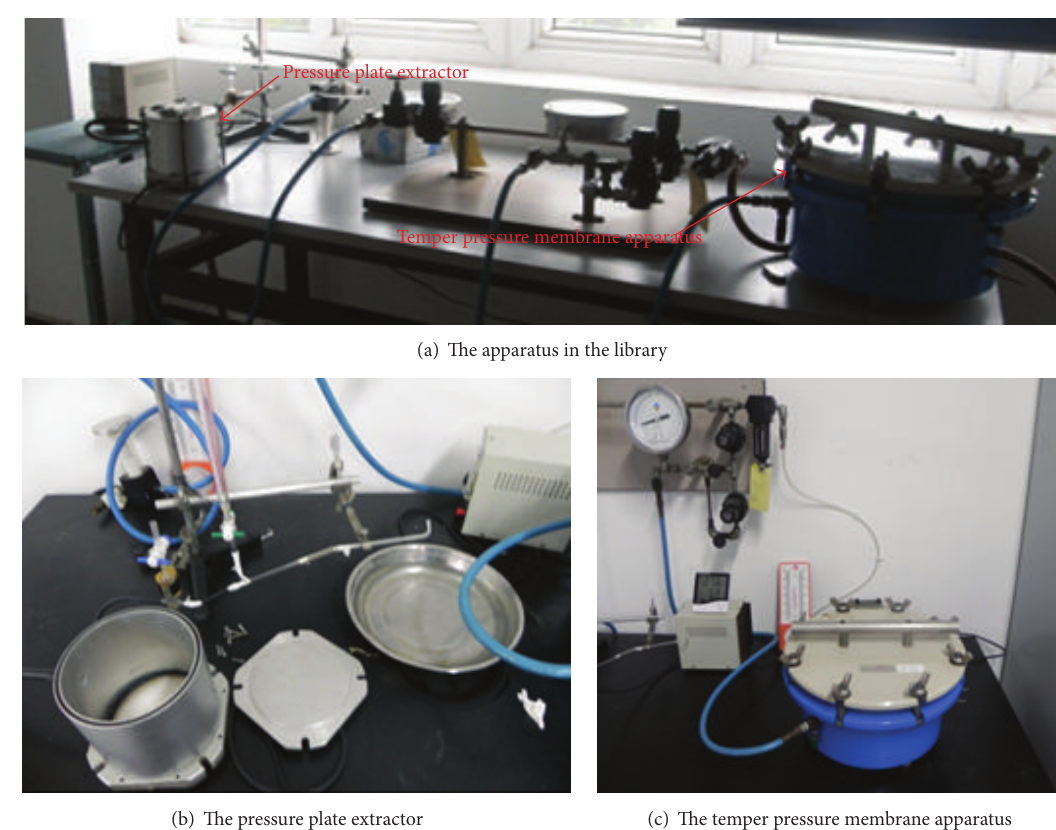
Figure 7: Apparatus for the measurement of SWCC.